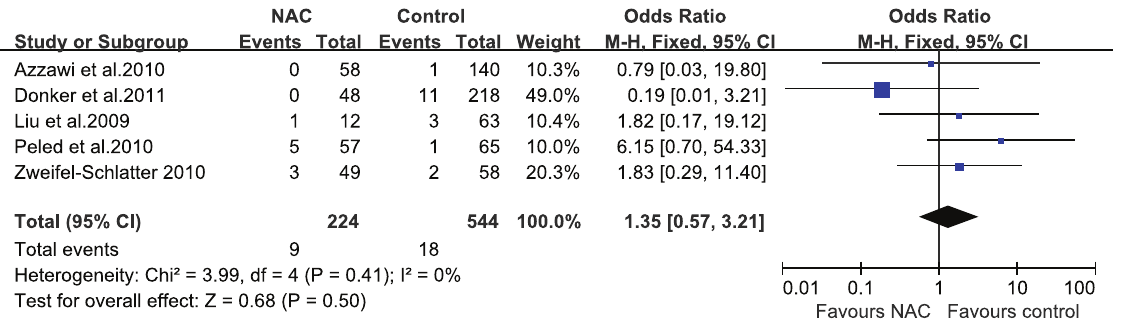
Figure 3. Pooled results of hematomas in patients treated with NAC. The size of the solid squares is inversely proportional to the variance of the study estimate. The diamond represents the fixed effects odds ratio and 95% confidence interval.